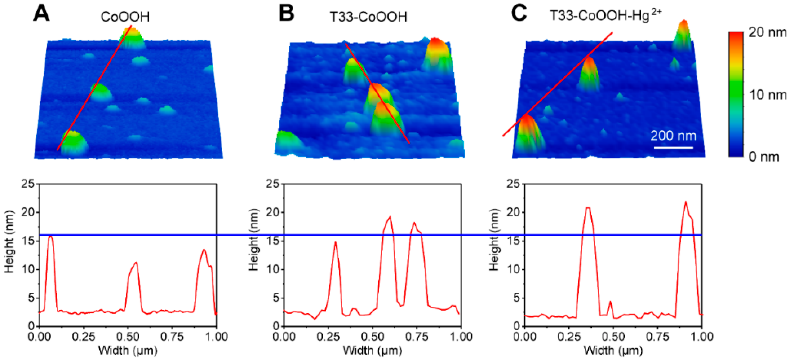
Figure 2. Representative atomic force microscopy (AFM) images and height analysis of ( A ) CoOOH; ( B ) T33–CoOOH; and ( C ) T33–CoOOH–Hg 2+ .